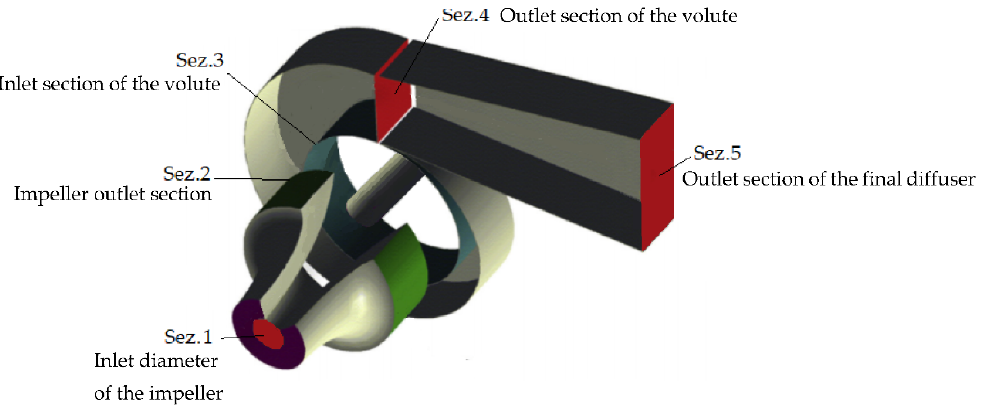
Figure 2. Reference geometry.